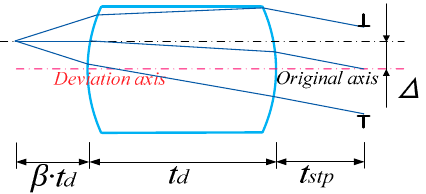
Figure 8. Schematic of the ray-tracing of the array system.